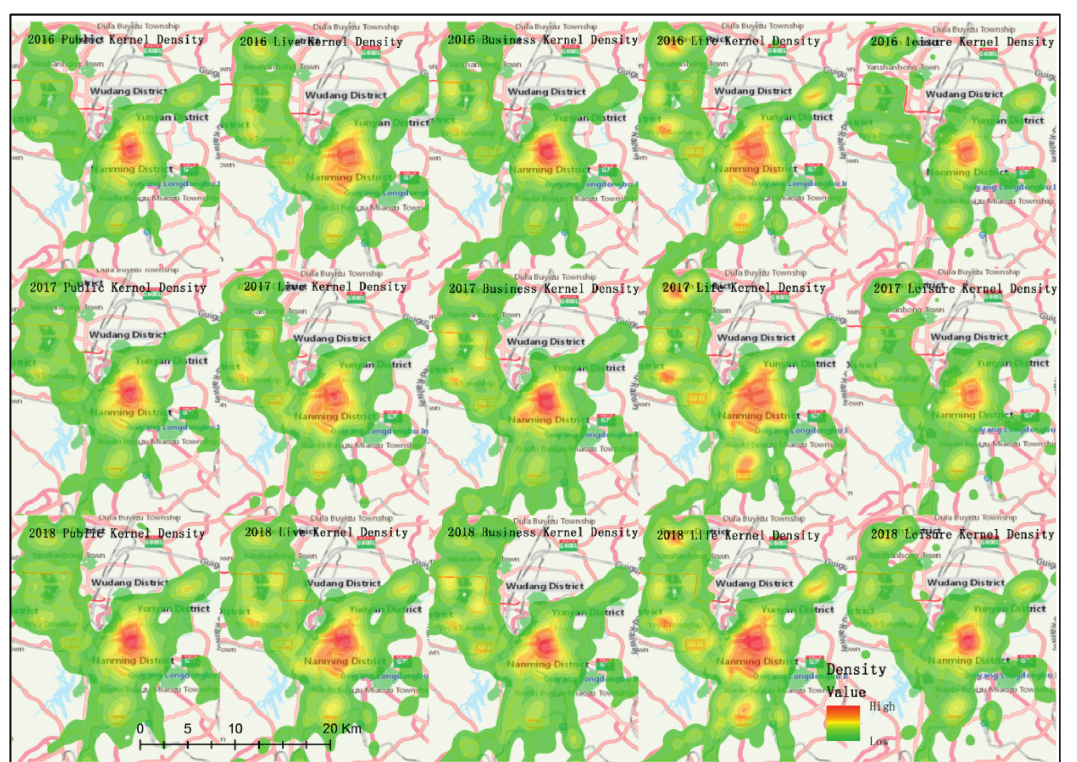
Figure 3: Nuclear density of different types of POIs from 2016 to 2018.